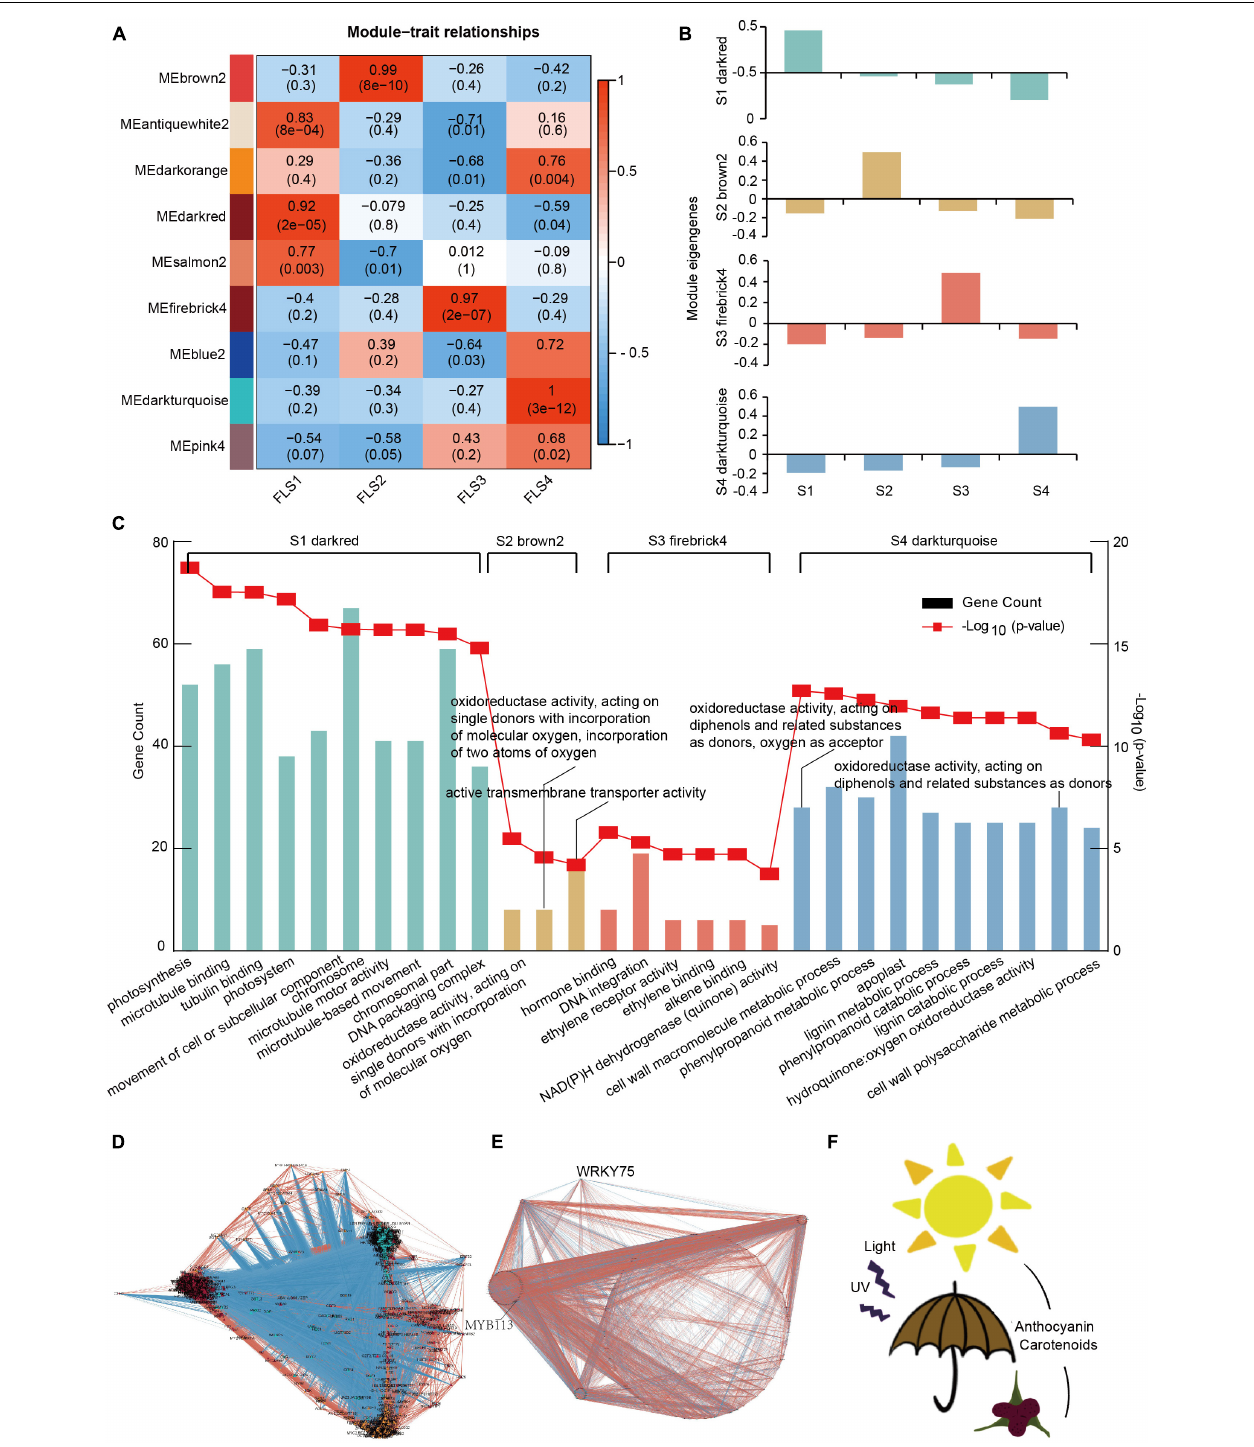
FIGURE 8 | Establishment of WGCNA modules of the differentially expressed genes (DEGs) at the four stages of hickory stigma. (A) Module-trait correlations and DEGs network analysis established by WGCNA. Colors indicated the strength and direction of the correlation according to the color legend at the right, and the color scale represented the module-trait correlations from − 1 to 1. The numbers in parentheses are the partial Pearson correlation coefficients and the corresponding P -values. (B) Module eigengenes of four hub modules. (C) GO analysis of four hub modules (darkred, brown2, firebrick4, and dark turquoise). (D) co-expression networks of anthocyanin, chlorophyll, carotenoid, ROS, and transcription factors in four modules. (E) co-expression networks of MYB113 and WRKY75 and pigments, ROS, TFs with the FPKM more than 10 at any stage. (F) The working module of hickory stigmas is photo protected by forming pigments, such as anthocyanins, to scavenge reactive oxygen